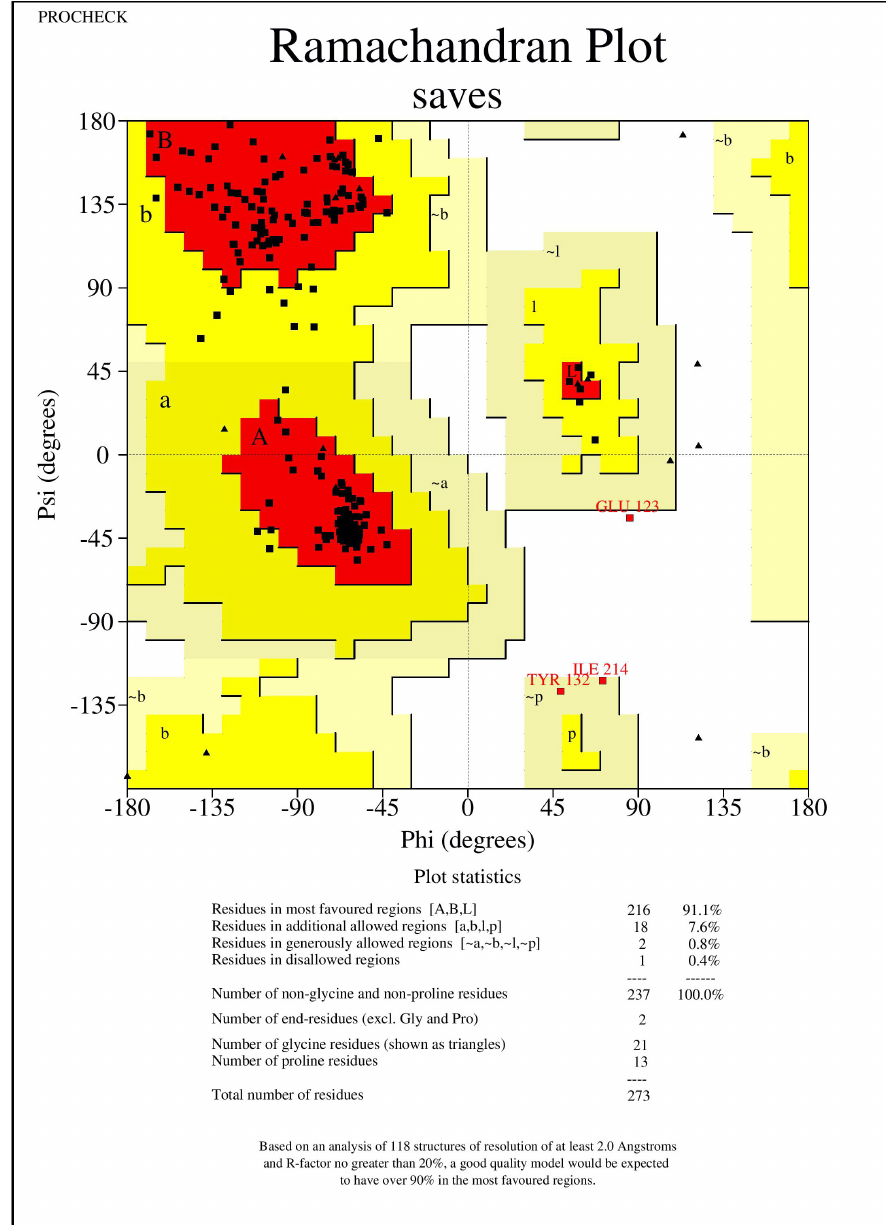
Figure 6. The Ramachandran plot generated from RAMPAGE. The Ramachandran plot representing energetically allowable regions for backbone dihedral angles ψ vs. φ amino acid residues in NQO1 (2F1O) protein